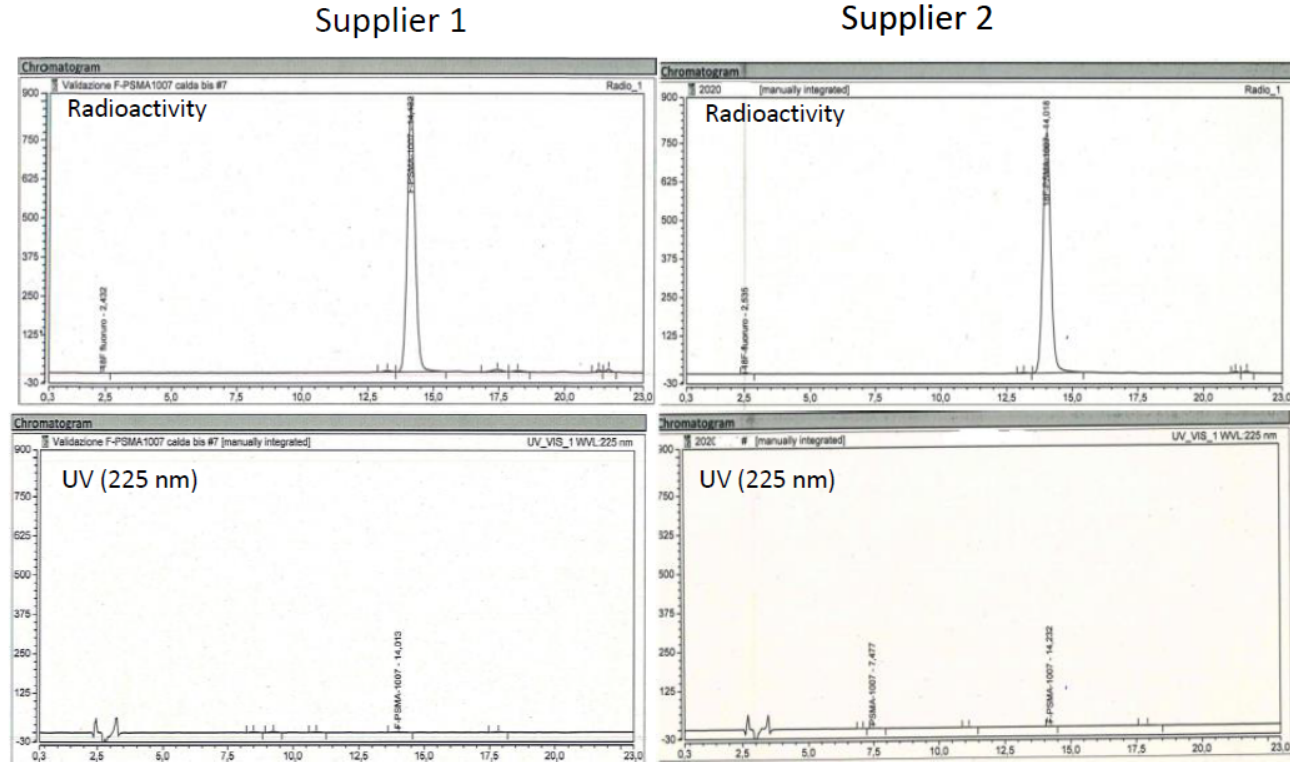
Figure 2. Relevant chromatogram of IMP [ 18 F] F-PSMA-1007 obtained with [ 18 F]F - from the two suppliers.